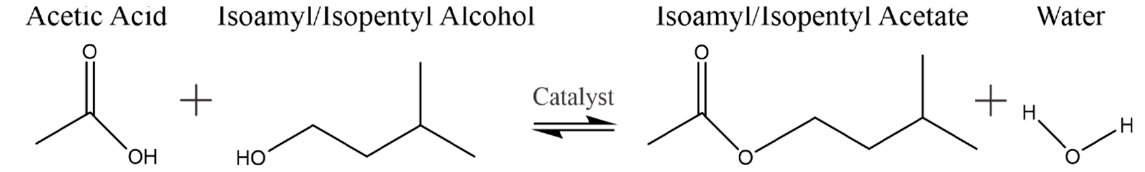
Figure 1. Conversion of Acetic Acid with Isoamyl Alcohol